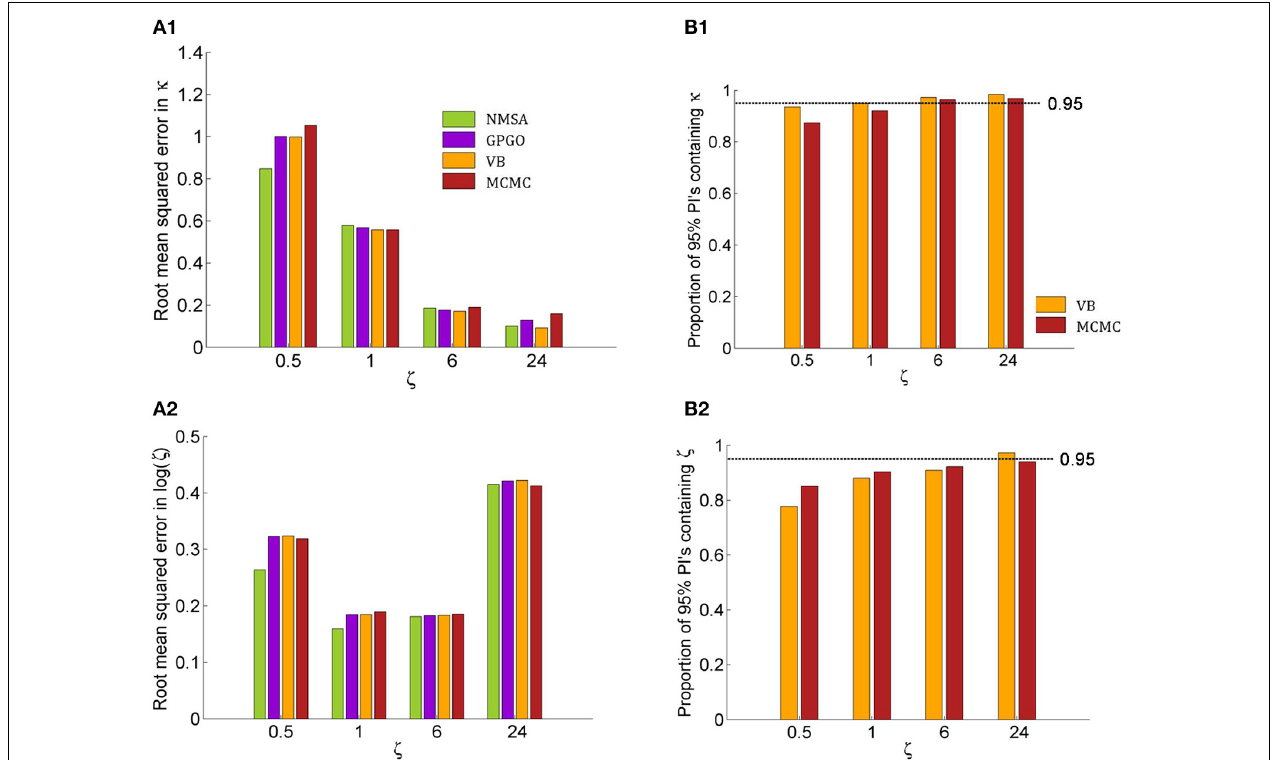
FIGURE 9 | Quantitative assessment of parameter estimation. (A) Root mean squared error of MAP estimates by noise level ζ for all four estimation methods (see Figure 7 for key to legends). (A1) Estimates for κ improve with decreasing noise and do not exhibit substantially significant differences between methods although NMSA is somewhat better at very high noise.